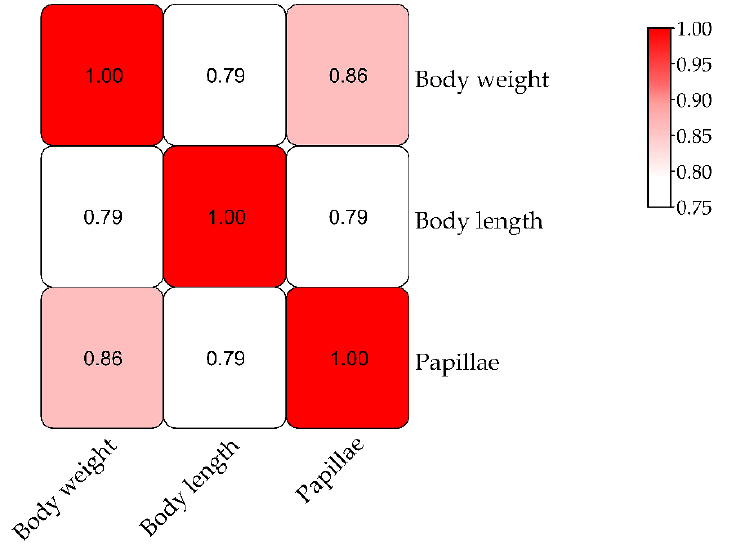
Figure 2. The frequency distribution of phenotypic data. ( a ) Body length; ( b ) body weight; ( c ) papil- lae number.